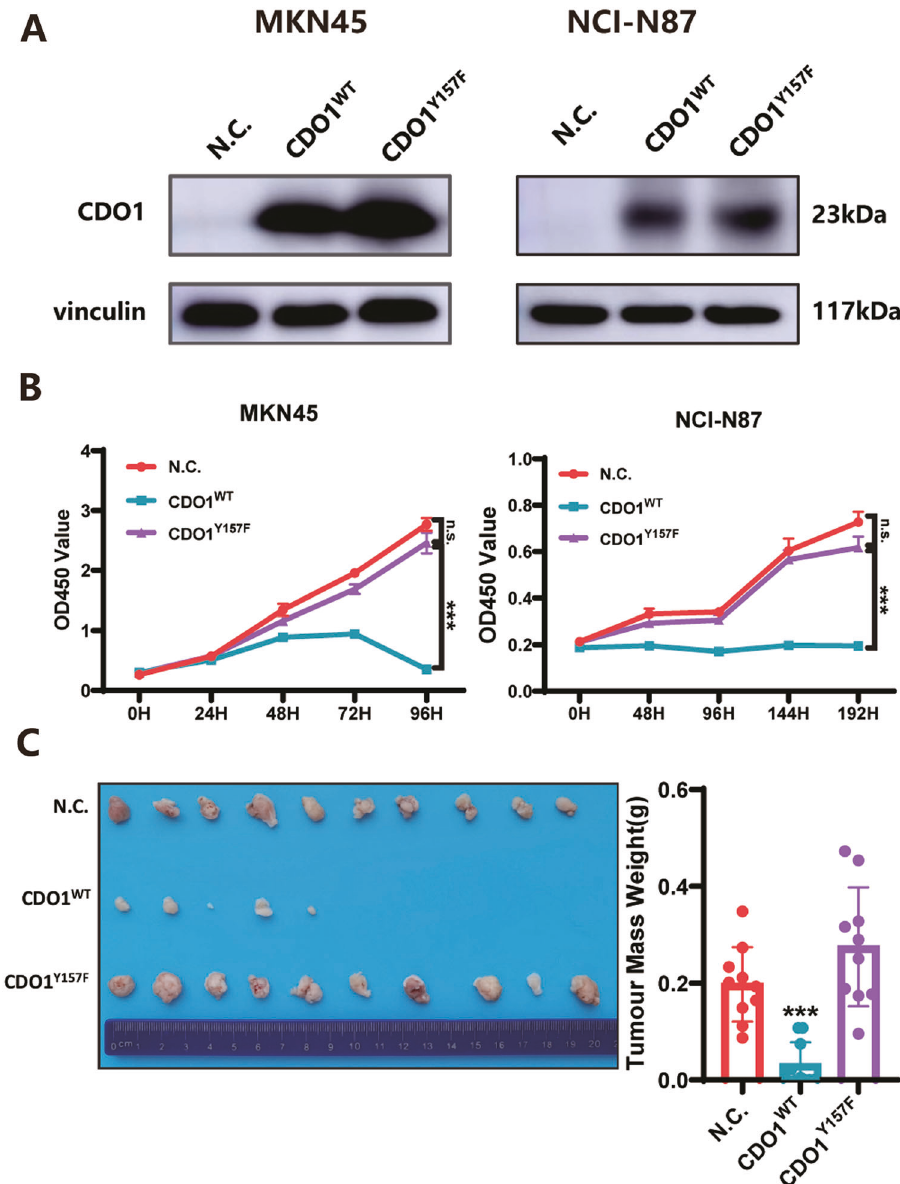
Fig. 3 The anti-proliferation function of CDO1 is in an enzymatic activity-dependent manner. A The expression ef fi ciency of CDO1 WT and CDO1 Y157F was con fi rmed via immunoblots in MKN45 (left panel) and NCI-N87 (right panel) cells. B CDO1 Y157F , unlike CDO1 WT , did not attenuate the growth of MKN45 (left panel) or NCI-N87 (right panel) cells in vitro, as indicated by CCK-8 assay at the indicated time points ( N = 6, mean ± SD). C Tumor xenografts model showed that CDO1 Y157F could not inhibit the growth of MKN45 cells in vivo. The tumor masses from the indicated three groups were photographed and weighed ( N = 10 mice per group). *** p < 0.001, n.s. means no signi fi